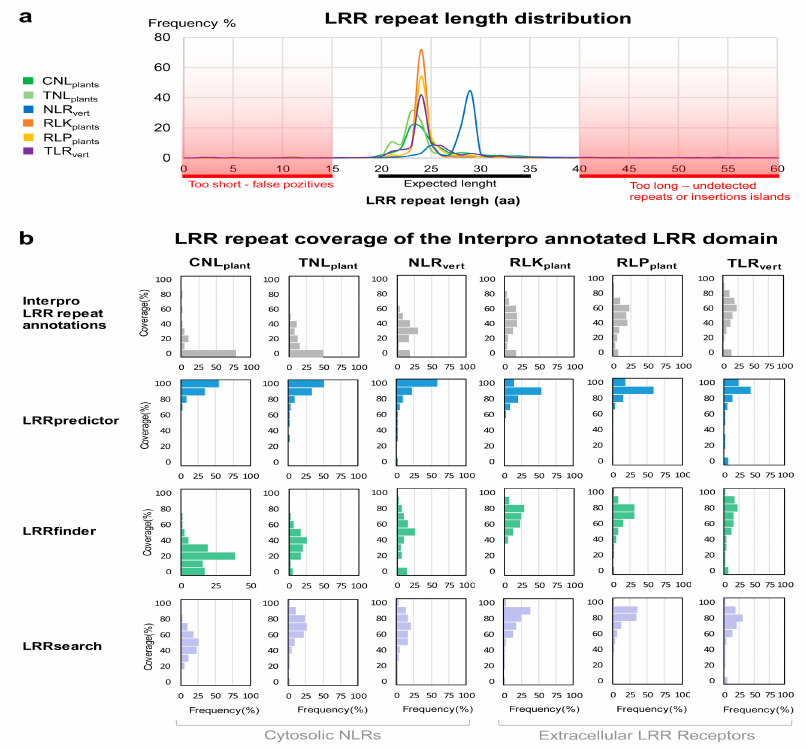
Figure 4. LRRpredictor behavior on Interpro annotated LRR domains from different classes. ( a ) Length distribution of the predicted repeats using LRRpredictor within each protein group. C-terminal motifs were not used in computing the distribution. Repeat lengths size prone to ambiguity—i.e., either too short (potential FP) or too long (potential FN)—are shaded in red. ( b ) Distributions of the Interpro annotated LRR domain length that is covered by Interpro LRR repeat annotations (grey) or by predicted repeats using LRRpredictor (blue), LRRfinder (green), and LRRsearch (purple). Coverage percent distributions are shown within each protein group.